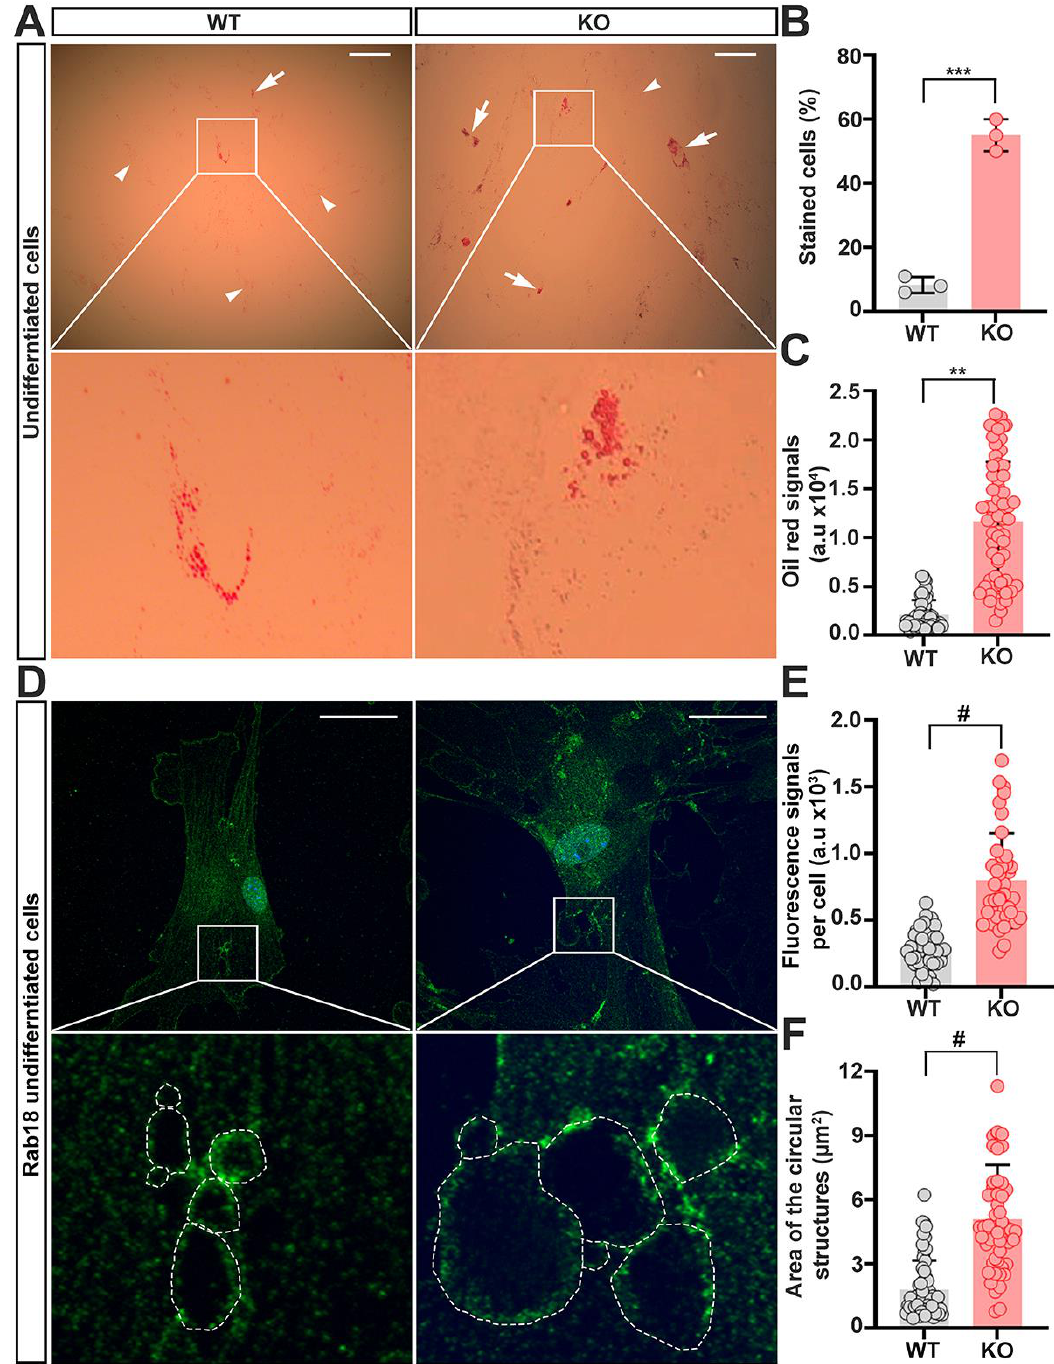
Figure 5. Enlargement of lipid droplets occurs in un-induced trappc9-deficient ASCs. WT and trappc9-deficient ASCs at passage-4 were seeded in 6-well plates with or without glass coverslips and cultured overnight. Cells in wells without glass coverslips were stained with oil red, whereas cells on glass coverslips were processed for immuno-labeling rab18. ( A ) Representative images of oil red stained cells. Enlarged boxed regions beneath the corresponding image showed clusters of enlarged lipid droplets in un-induced trappc9-null (KO) ASCs. Arrows identified cells having clustered large lipid droplets, whereas arrowheads indicated cells lacking such clustered lipid droplets. Scale bars: 100 μ m. ( B ) Cell counting revealed more trappc9-defidient (KO) ASCs displaying clustered lipid droplets than WT ASCs. For each of 3 independent experiments, 100 cells were counted from 3 images taken from randomly chosen and non-overlapped visual fields. ( C ) Densitometry of oil red signals suggested greater accumulation of lipids in trappc9-null (KO) ASCs than in WT ASCs. ( D ) Representative confocal images of cells labeled